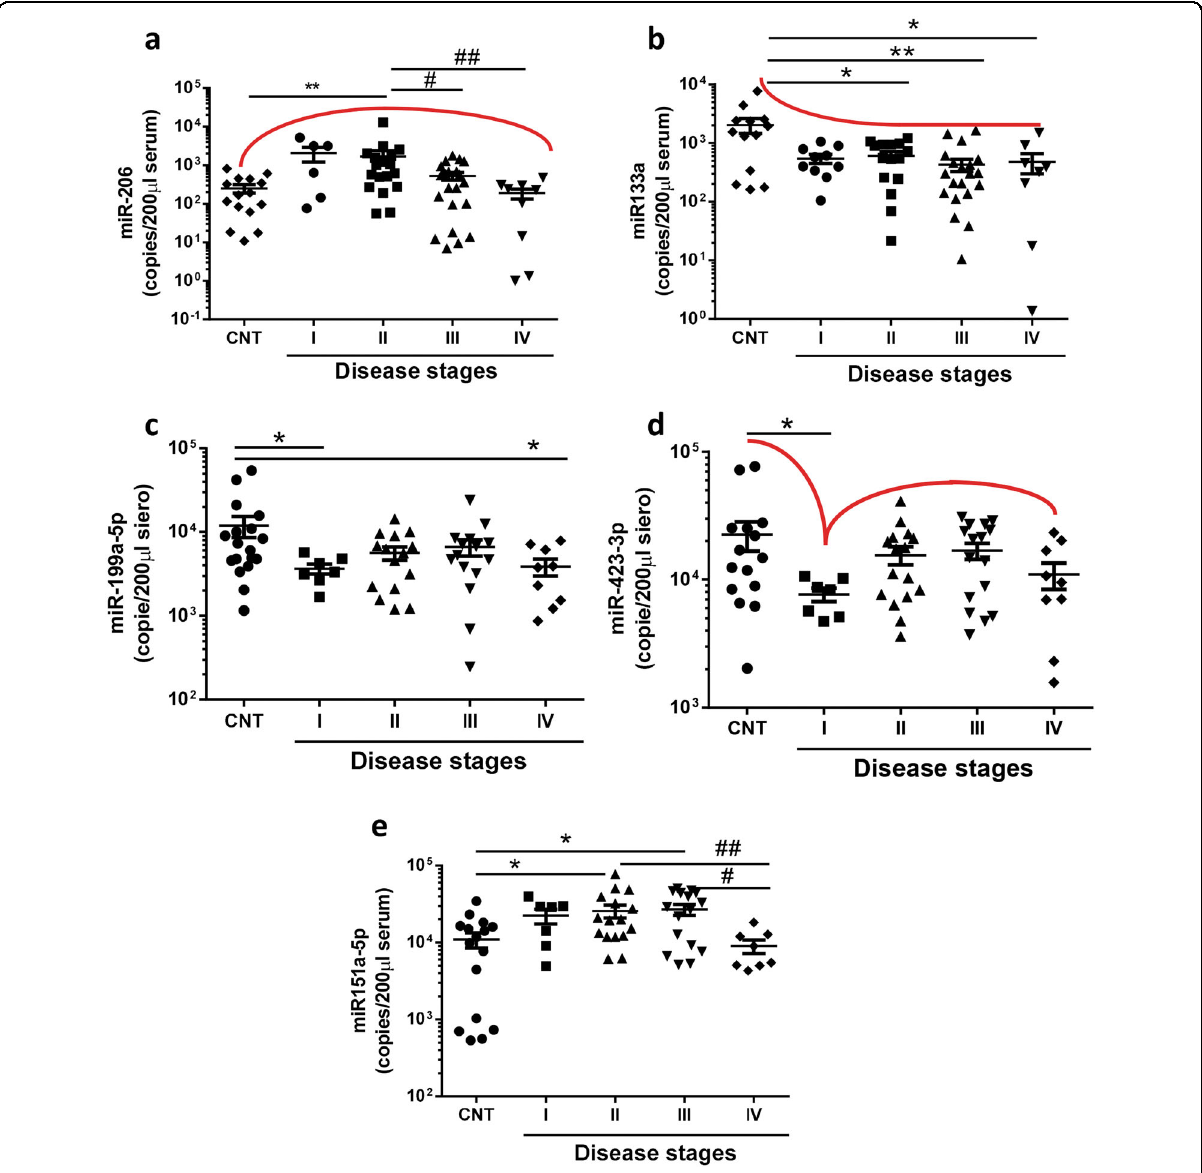
Fig. 3 MiRNAs expression level at different stages of the disease. MiRNAs absolute RT quanti fi cation indicted that a miR-206, b miR-133a, c miR- 199a-5p, d miR-423-3p and e miR-151a-5p are differentially modulated in ALS patients at mild (I) moderate (II), severe (III), and terminal (IV) stages compared to control individuals. Graphs indicate mean ± SEM; a N = 15 (CNT), 6 (I), 18 (II), 21 (III), 9 (IV); b N = 13 (CNT), 10 (I), 15 (II), 20 (III), 8 (IV) c N = 18 (CNT), 7 (I), 15 (II), 15 (III), 9 (IV); d N = 15 (CNT), 7 (I), 16 (II), 16 (III), 9 (IV); e N = 16 (CNT), 7 (I), 16 (II), 16 (III), 8 (IV); Mann – Whitney test: control vs stages * p < 0.05 ** p < 0.01; Mann – Whitney test between stages # p < 0.05 ## p <